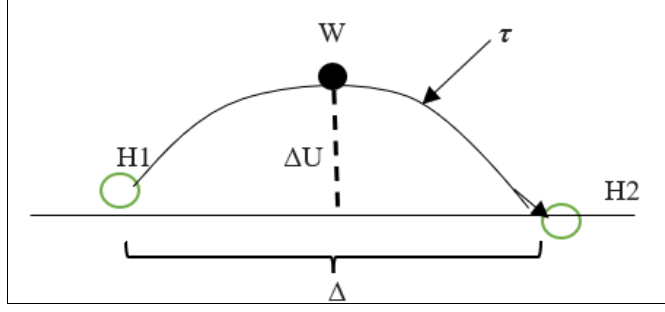
Figure 10: Jump of the particle, from one hole to another. Source: Authors, (2023).